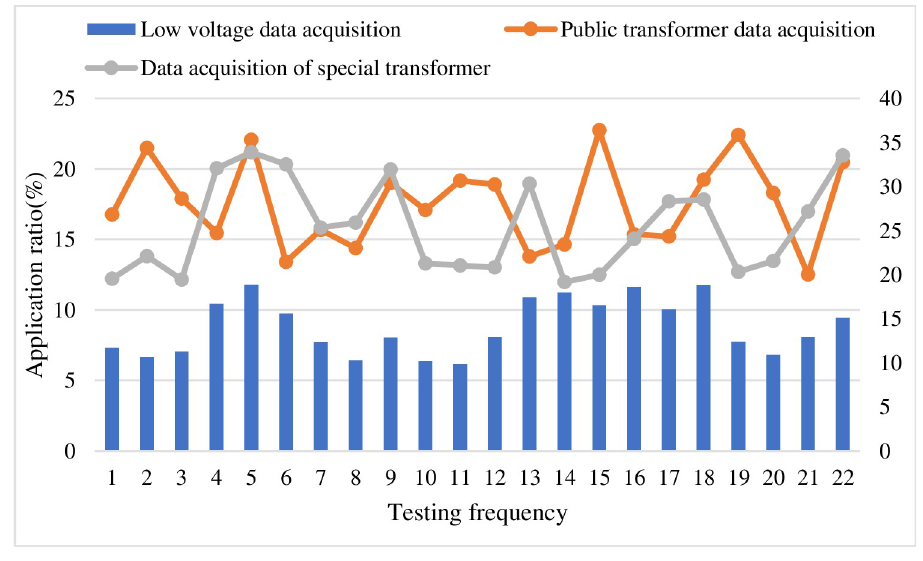
Fig 12. The logistics cost.